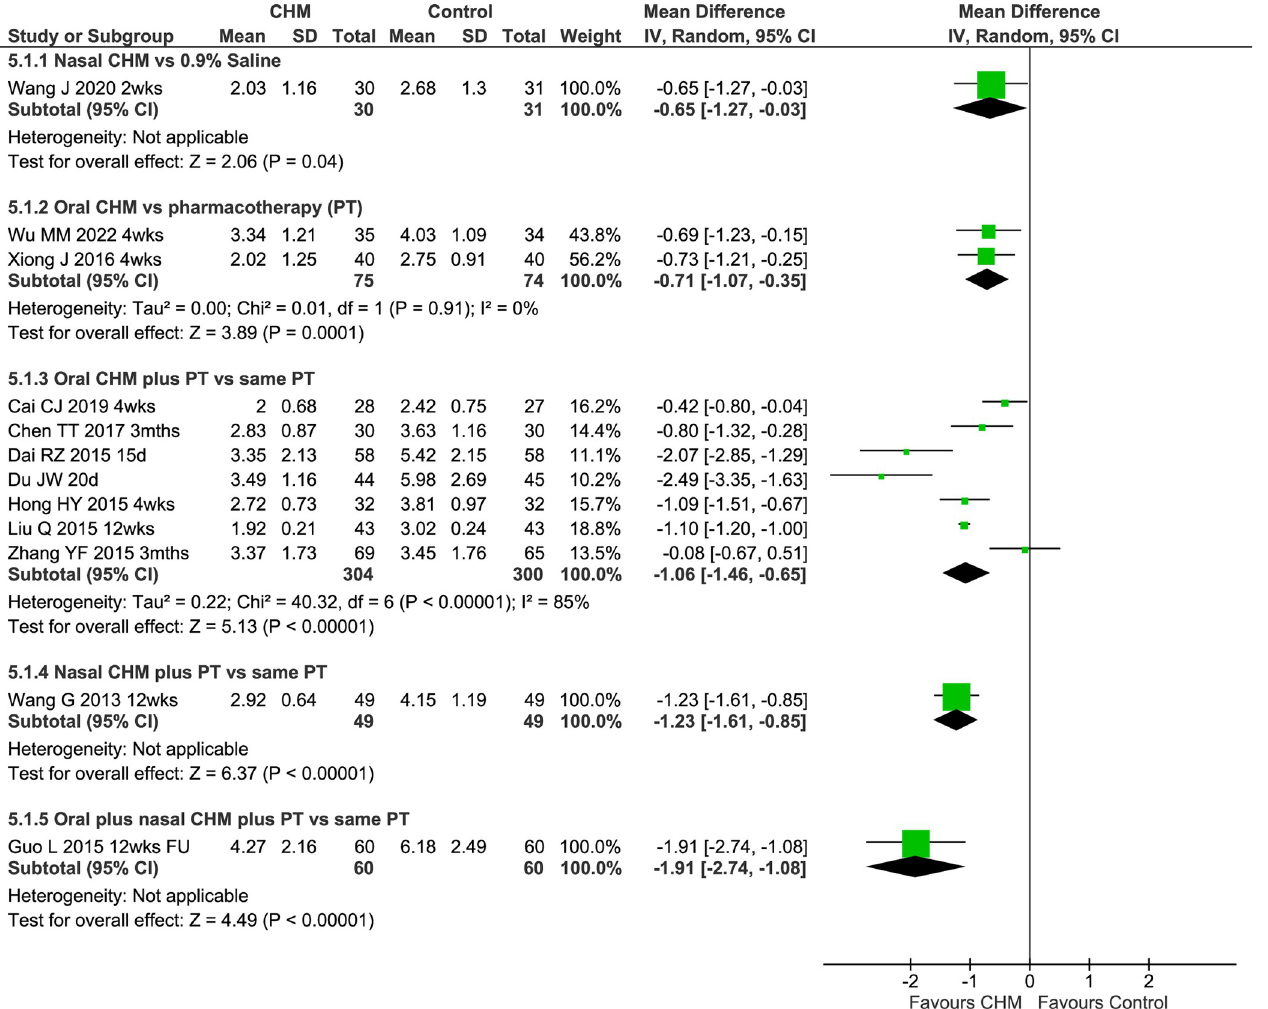
Fig 5. Forest plot of CHM for CRS at end of treatment for LK. Abbreviations: CHM: Chinese herbal medicine; CRS: chronic rhinosinusitis; FU: follow-up; LK: Lund-Kennedy endoscopic score; PT: pharmacotherapy; vs: versus; wks: weeks.